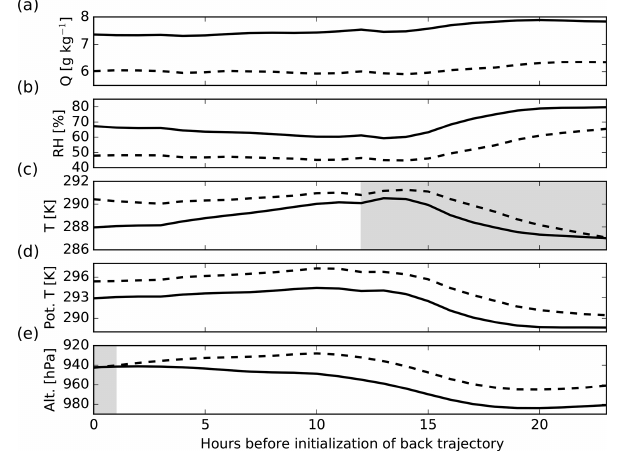
Figure 8. Hourly averaged (a) specific humidity, (b) relative humid- ity (RH), (c) air temperature ( T ), (d) potential temperature (pot. T ), and (e) pressure ( P ), along the 24h air-mass back trajectories that are advected from the marine boundary layer on FLC days (solid line) and clear days (dashed line) during SON 2004–2017. The number of samples are 369 FLC days and 80 clear days. Grey shad- ing highlights nonsignificant